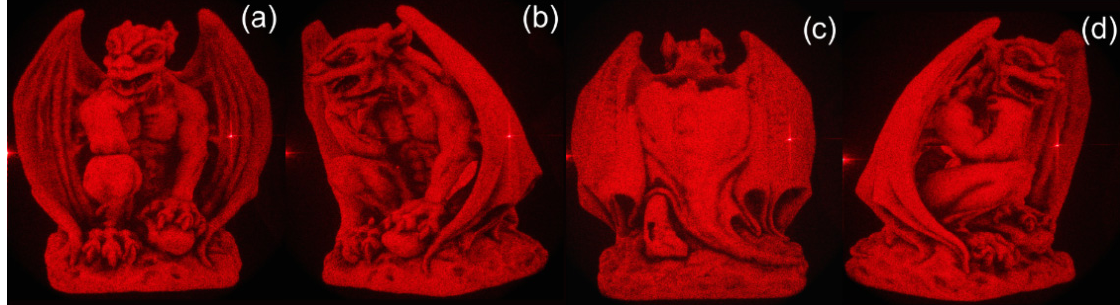
Figure 9. Optical reconstructions of CGHs generated with culling-occlusion-PAS-based algorithm for different view angles: ( a ) 0°, ( b ) 45°, ( c ) 180°, and ( d ) 275°.